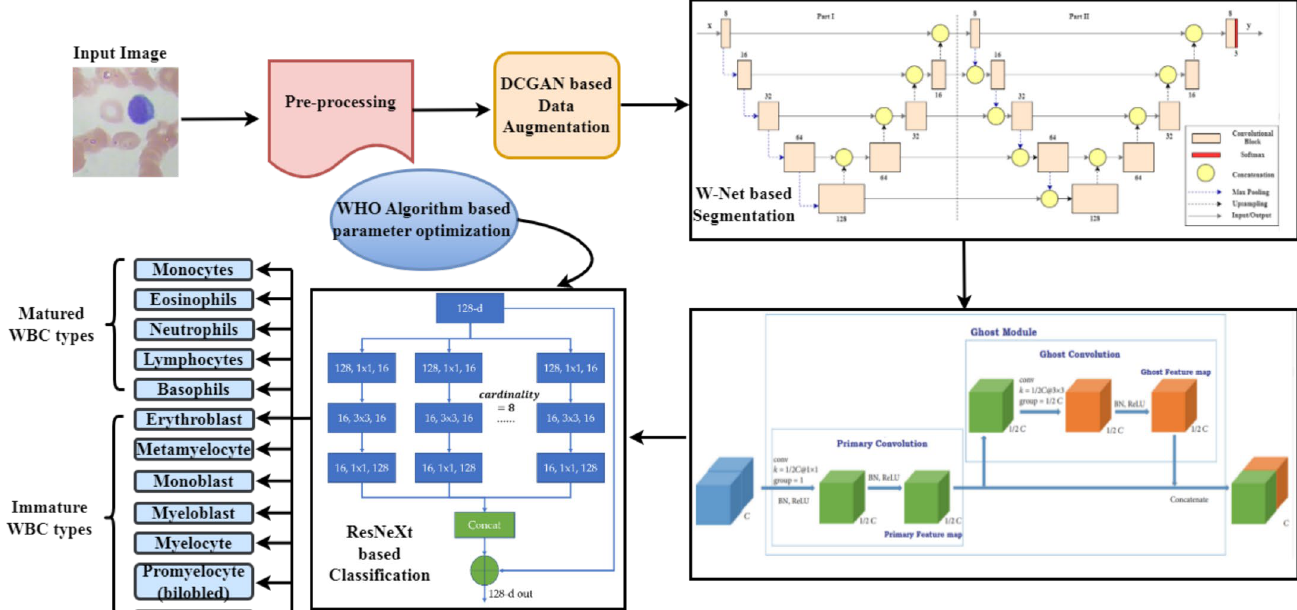
Figure 1. System architecture of the proposed framework.